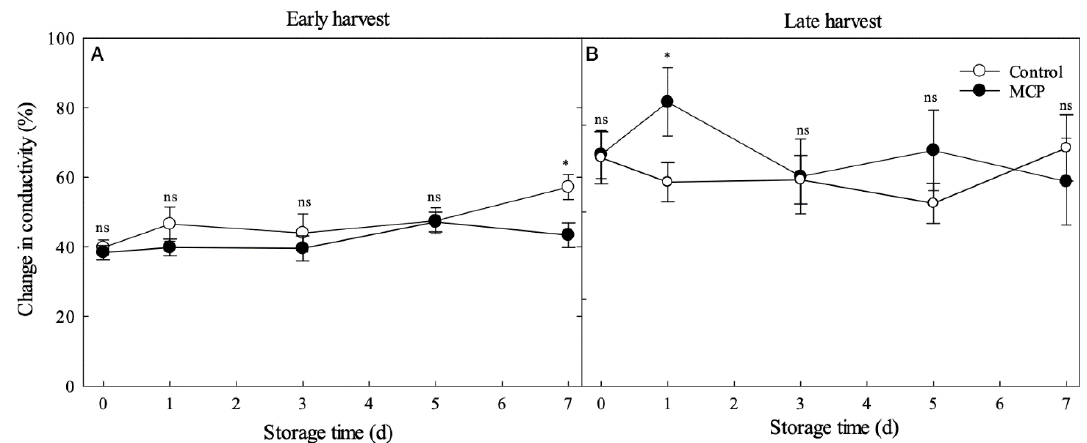
Figure 5. Leakage of early ( A ) and late-harvested ‘Empire’ apples ( B ) and stored at 0.5 °C in air storage up to 7 months and evaluated for 7 days at 20 °C. Bars represent error of the means (SEM; n = 5), when larger than the dimension of the symbol. * Adjacent to each data point each storage time indicates significant differences as determined by Duncan’s multiple range test at p ≤ 0.05; ns—not significantly different.